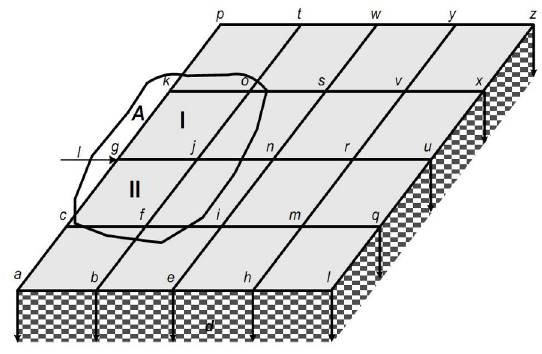
Figure 1. Four Meshes Section for